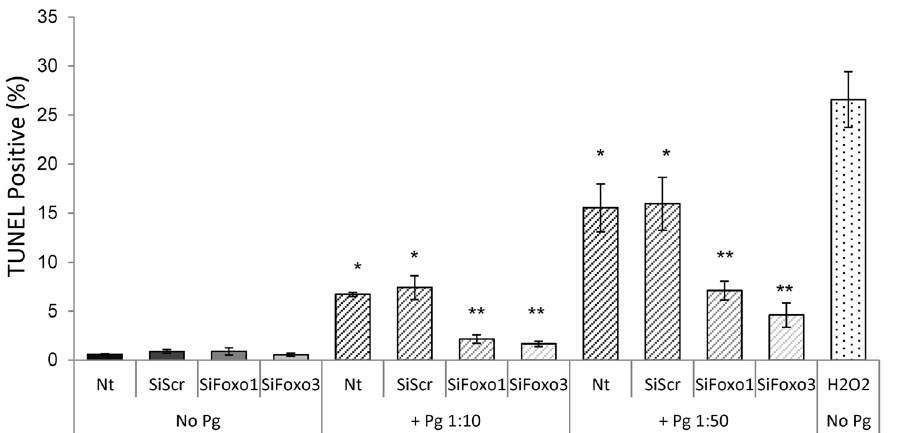
Figure 9. P.gingivalis induces gingival epithelial cell apoptosis through FOXO1 or FOXO3. Primary human gingival epithelial cells were incubated with or without P. gingivalis at MOI=1:10 or 1:50 for overnight. In some cases cells were pre-incubated with FOXO1 siRNA (SiFOXO1), FOXO3 siRNA (SiFOXO3) or scrambled siRNA (SiScr) prior to incubation with bacteria. Apoptotic cells were assessed by the TUNEL assay. * Significantly different from control cells with bacterial stimulation (P , 0.05). ** Significantly different between scrambled siRNA and FOXO1 or FOXO3 siRNA (P , 0.05).